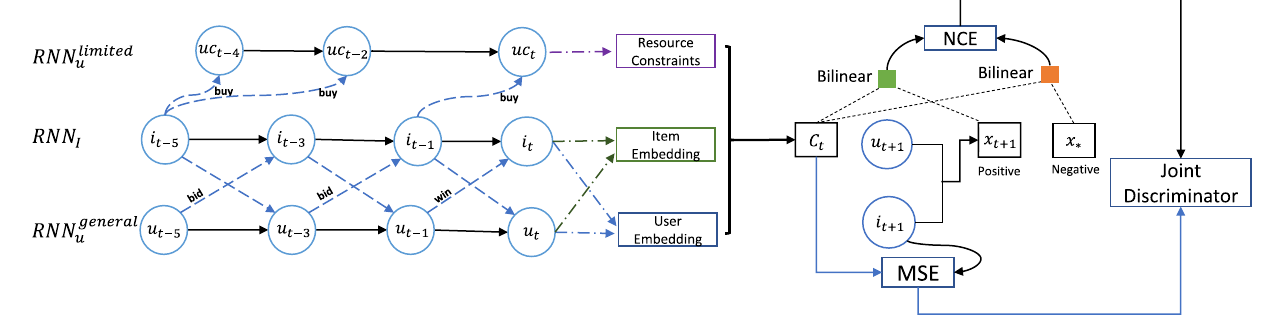
Fig. 1 Illustration of our model achitecture. ‘NCE’ are the contrastive loss function built by the mutual information between history con- text and future item targets. ‘MSE’ are Mean Squared Error between prediction and ground truth. RNN limited U